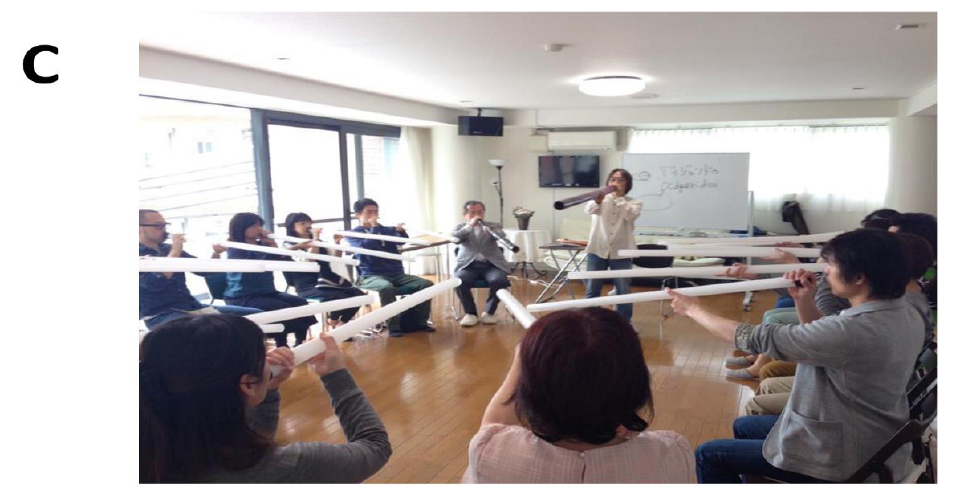
Figure 1. Didgeridoo performance and health promotion method classroom. ( A ) Just before playing the didgeridoo. ( B ) Various didgeridoos. ( C ) A lesson of the Didgeridoo Health Promotion Method in